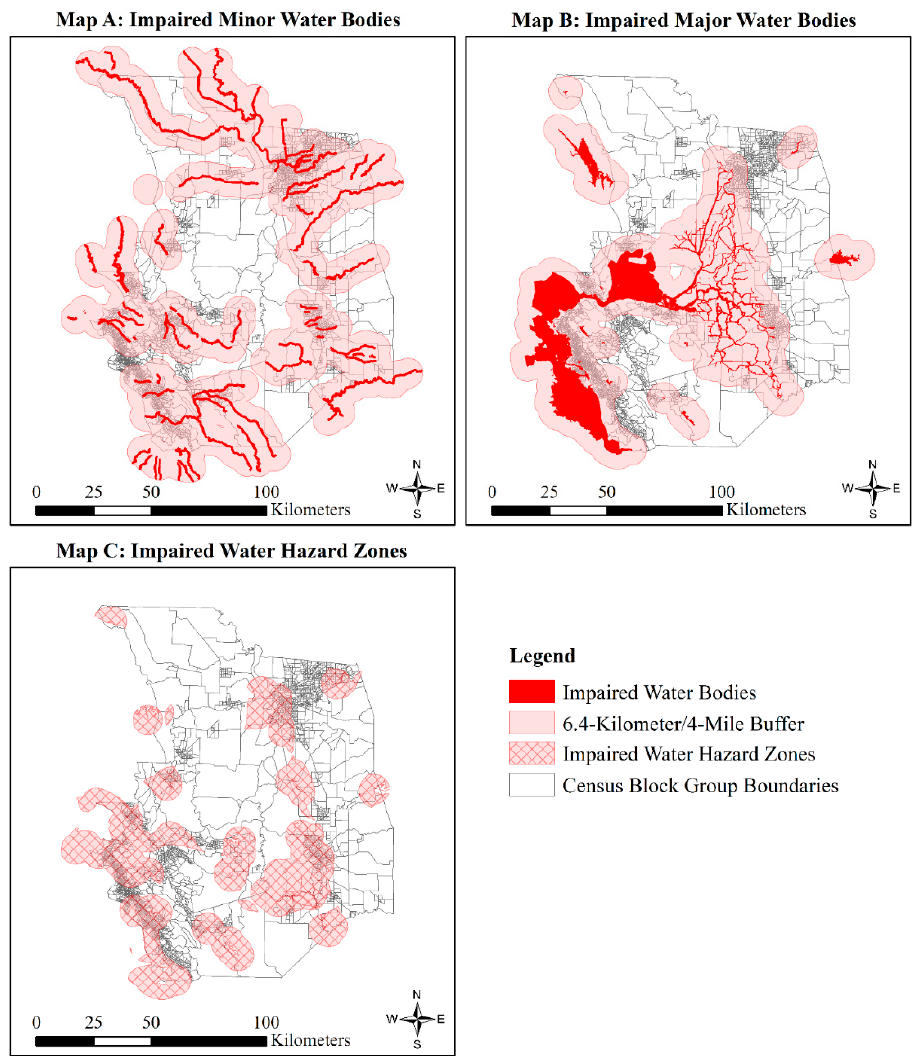
Figure 3. Illustration of Map ( A ) the impaired minor water bodies and their buffers, Map ( B ) the impaired major water bodies and their buffers, and Map ( C ) the impaired water hazard zones that result from intersecting the buffers for impaired minor and major water bodies in the Bay-Delta, 2006.